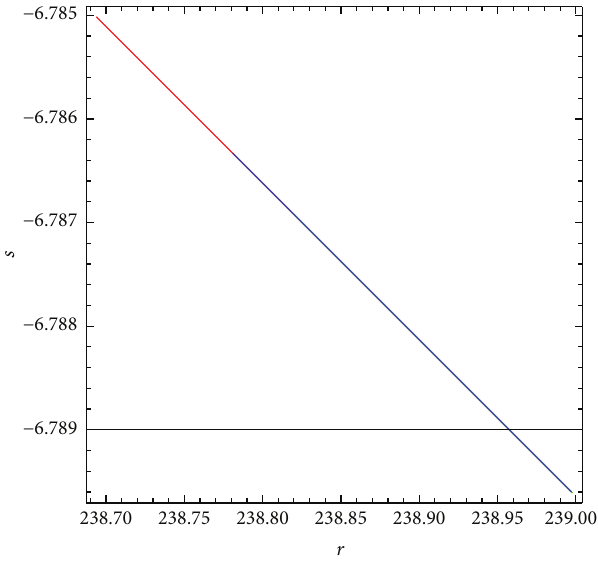
Figure 9: State-finder trajectories based on